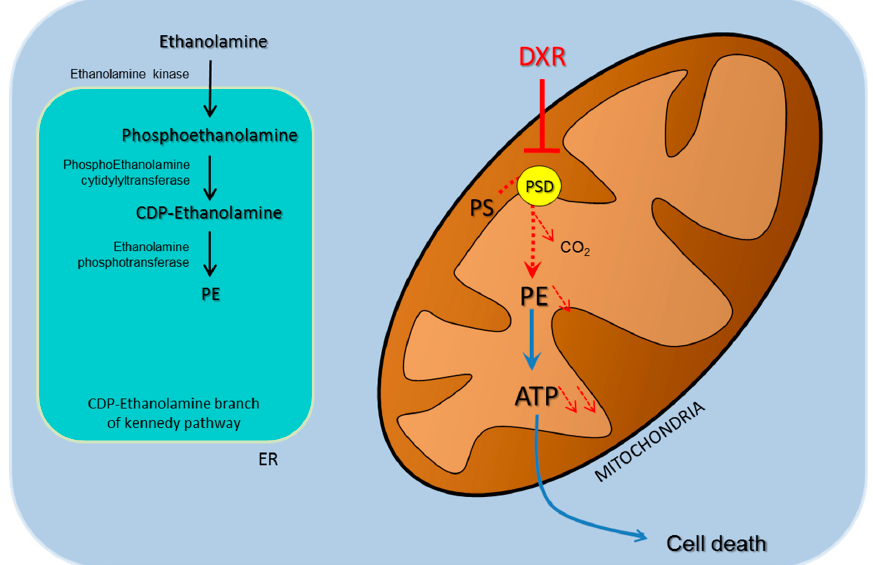
Figure 5. Model of doxorubicin action’s specificity. DXR inhibits PSD activity, alters mitochondrial membrane composition, and triggers impairments in the oxidative phosphorylation (OXPHOS) system that will lead to apoptosis on cells that rely on the PSD pathway as a primary source for the mitochondrial pool of